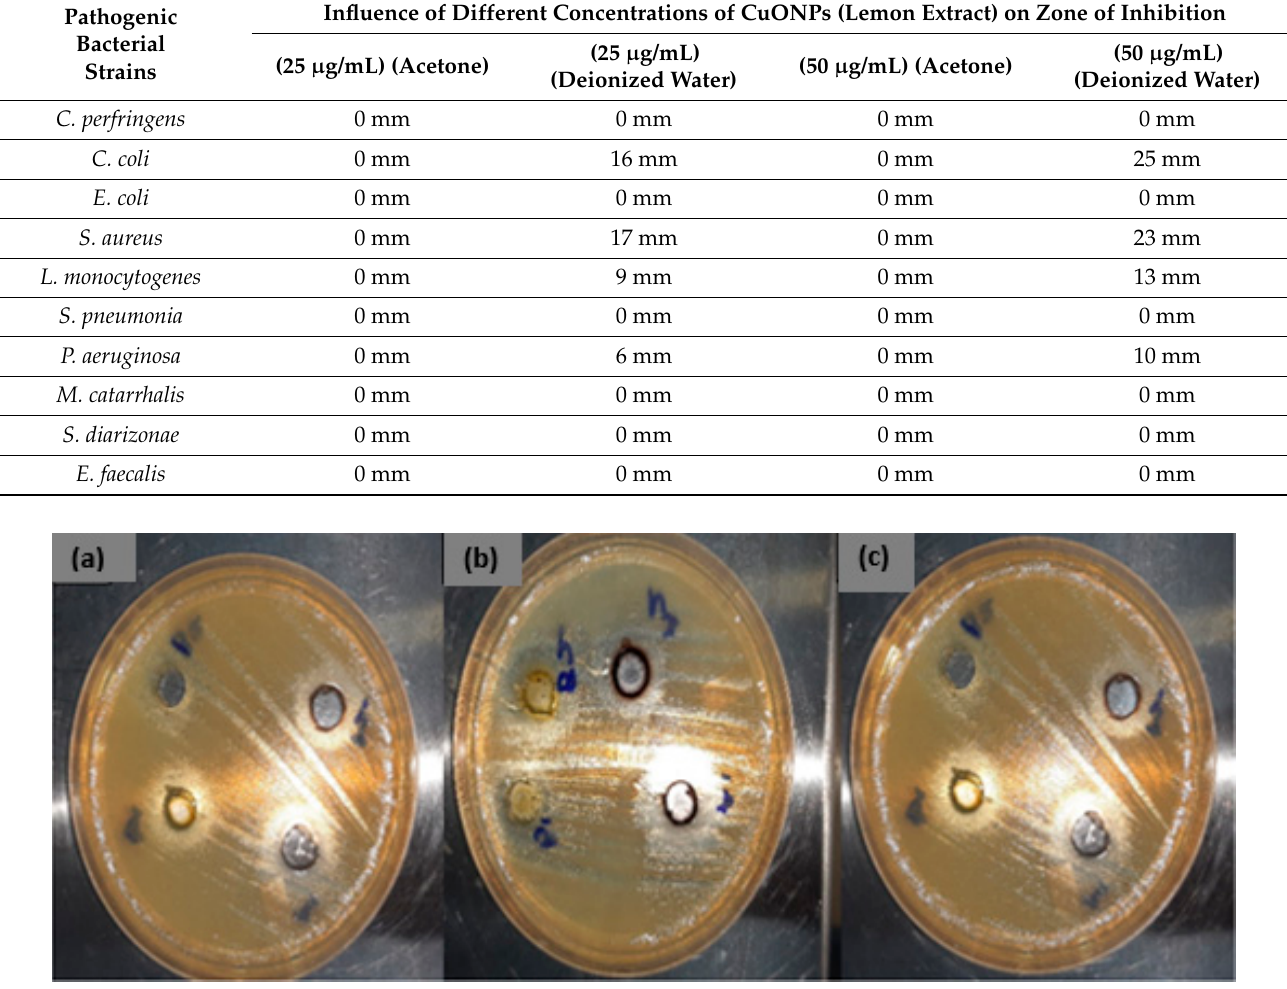
Table 4. Antibacterial activity of CuO-NPs-L on pathogenic bacterial strains.